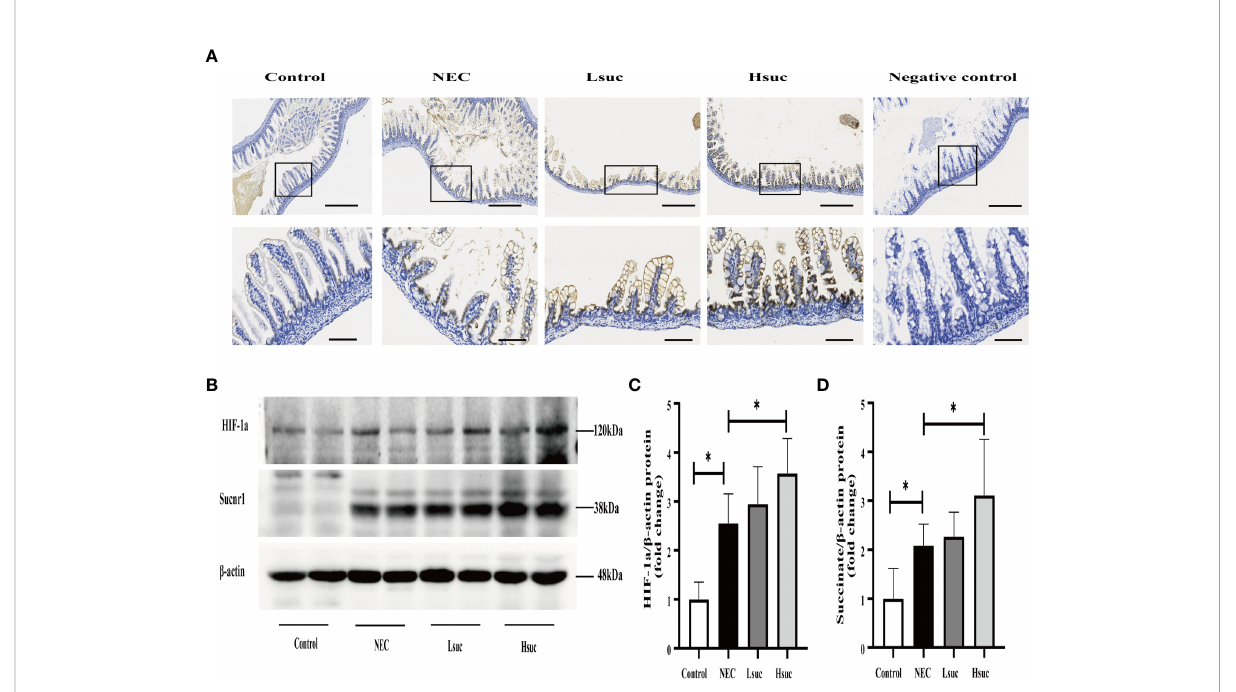
FIGURE 8 Succinate increases the protein expression of SUCNR1 and HIF-1a in mice. (A) Sucnr1 staining intensi fi es with an increasing of succinate concentration. Representative images of immunohistochemical staining for SUCNR1 in the control group and the NEC, Lsuc and Hsuc groups (n=3 per group). SUCNR1 localizes to the intestinal epithelium and lamina propria cells. Original magni fi cation: ×100 and ×400; scale bar, 100 m m and 20 m m. (B – D) A representative western blot and graphs showing SUCNR1 and HIF-1a protein levels in intestine samples from four independent groups (n=7 per group and n=5 per group, respectively). The bars in the graph represent the means ± SD. Statistical signi fi cance was assessed with one-way ANOVA followed by Dunnett ’ s post hoc test. * P <